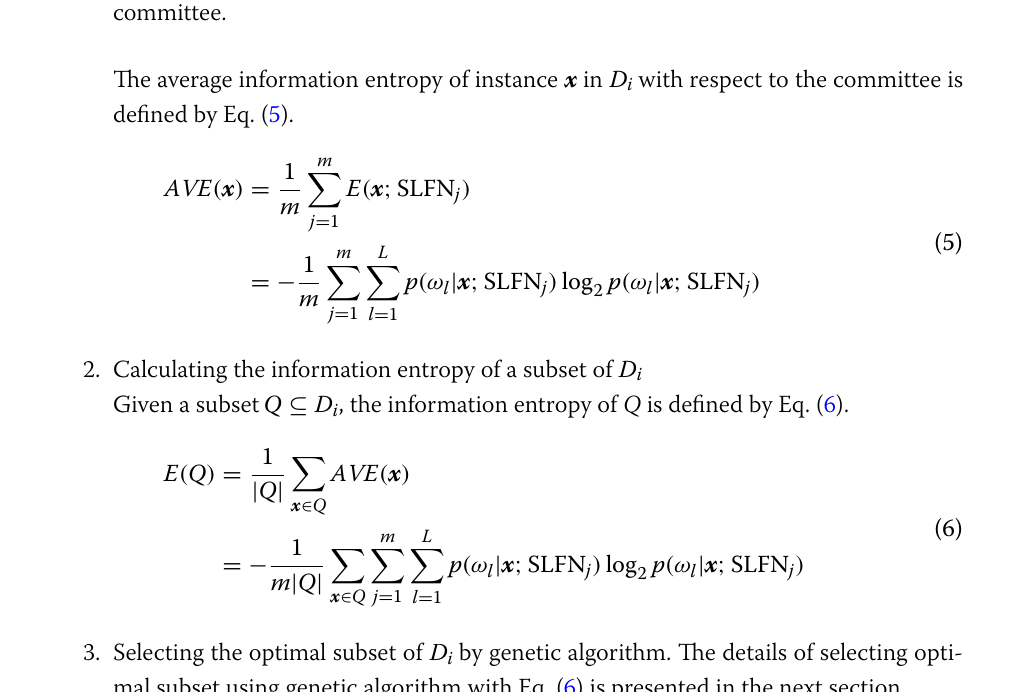
Optimal subset selection via genetic